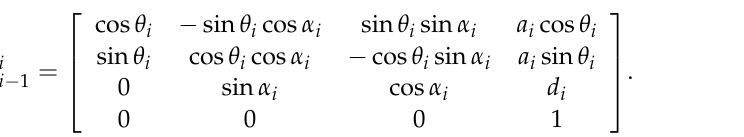
Figure 2. The D–H coordinate system of the manipulator.